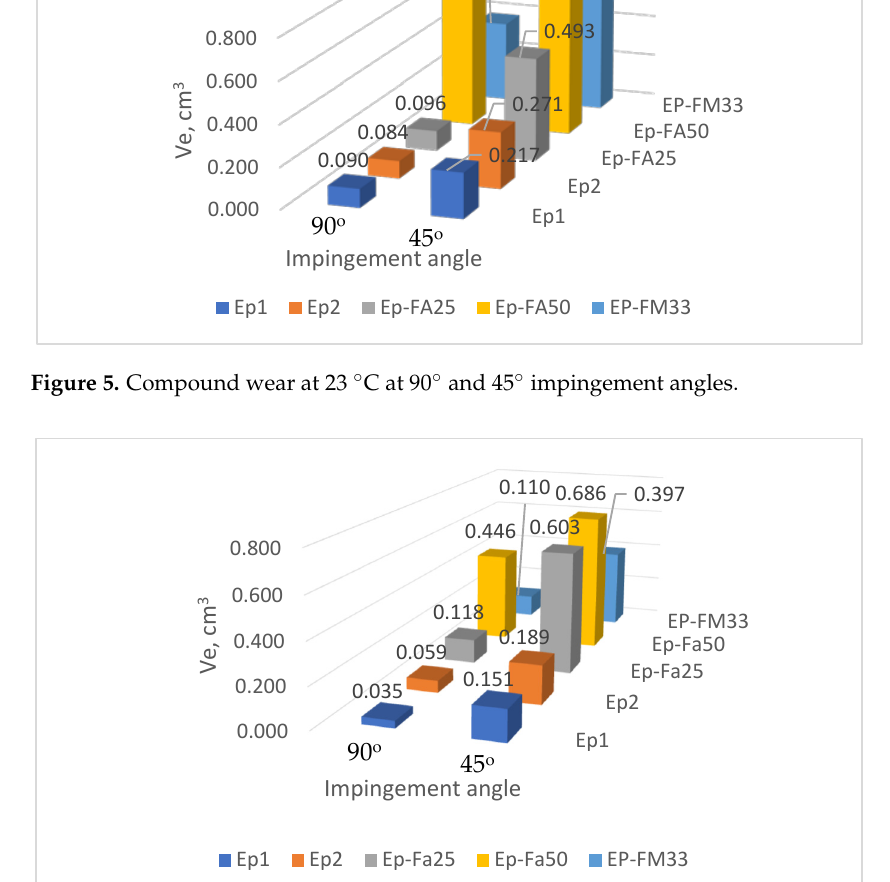
Figure 6. Compound wear at 100 °C at 90° and 45° impingement angles.